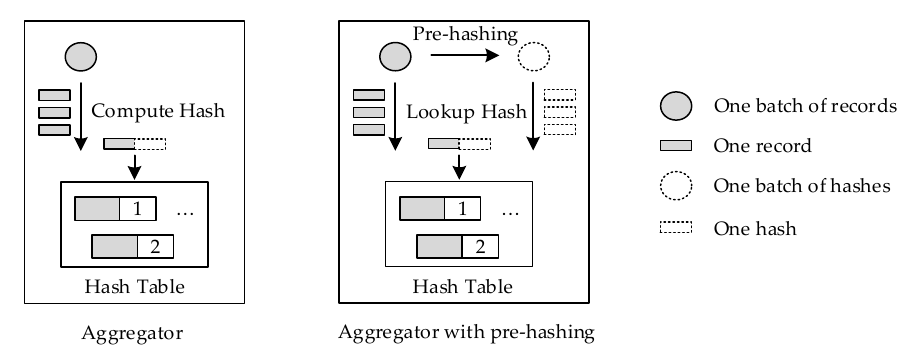
Figure 7. Comparison of vectorized aggregation implementations with and without pre-hashing.